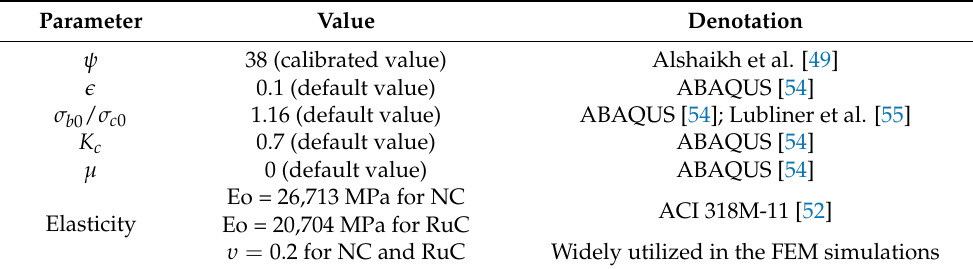
Table 2. The primary parameters of the CDP material model used in this study.